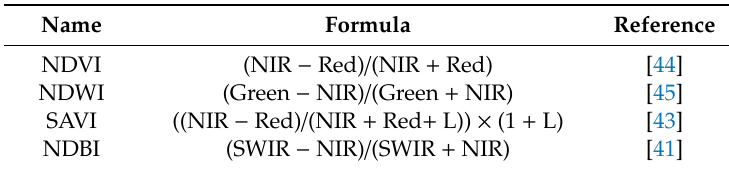
Table 1. List of generated spectral indices and their corresponding formulas (NIR = near infrared, SWIR = short wave infrared, L = 0.428).